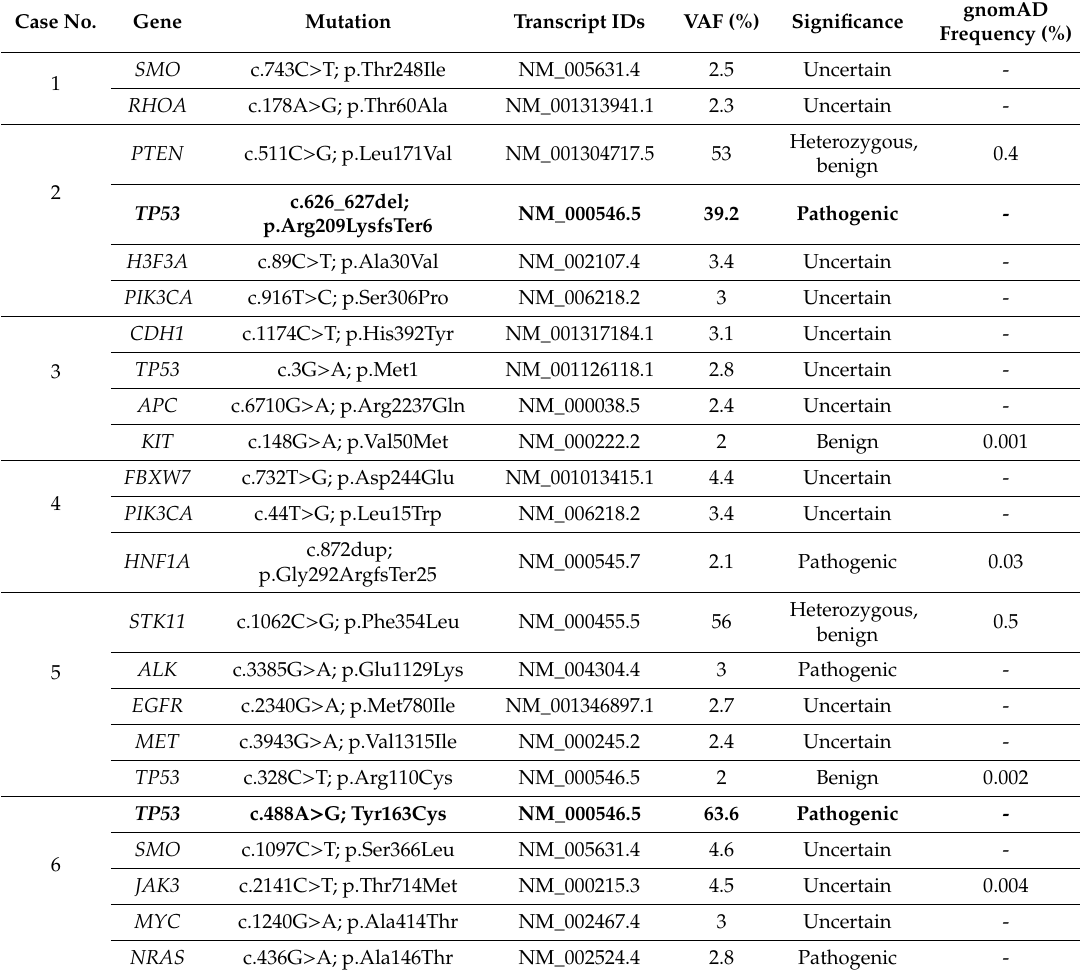
Table 2. Next generation sequencing result of six ACA / CAS